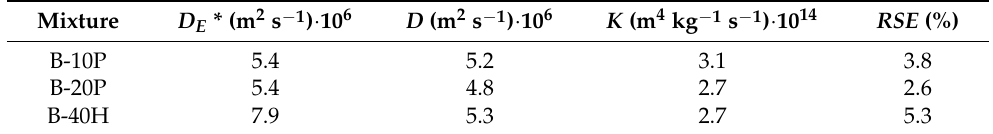
Table 5. Diffusion ( D E and D ) and convective ( K ) coefficients and relative standard error ( RSE ) of the binary mixtures after the optimization process using Scilab.